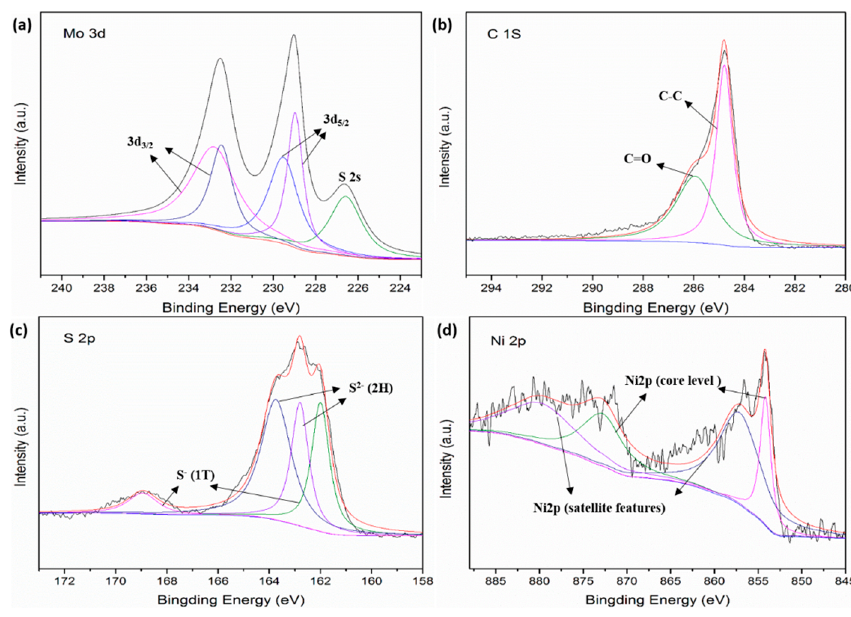
Figure 3. XPS spectra of ( a ) Mo 3d, ( b ) C 1s, ( c ) S 2p, and ( d ) Ni 2p.